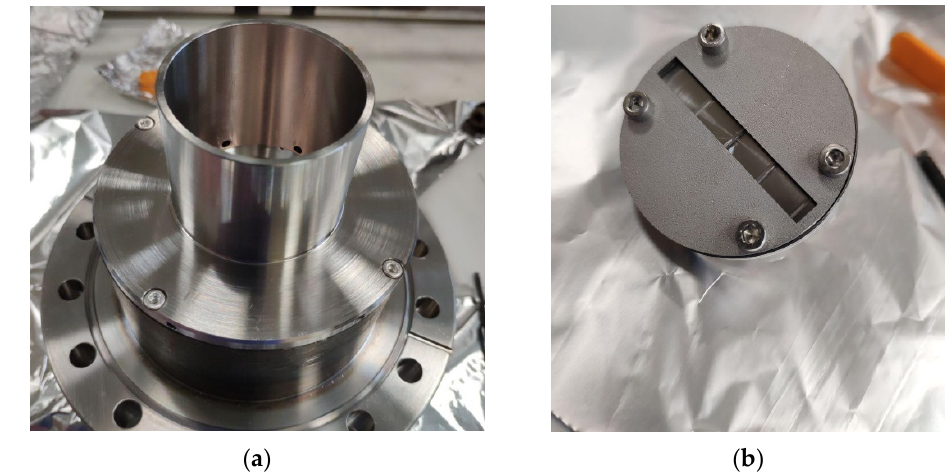
Figure 2. New recovering shield mounted on the 2 inches magnetron source ( a ); sample holder with quartz samples ( b ).